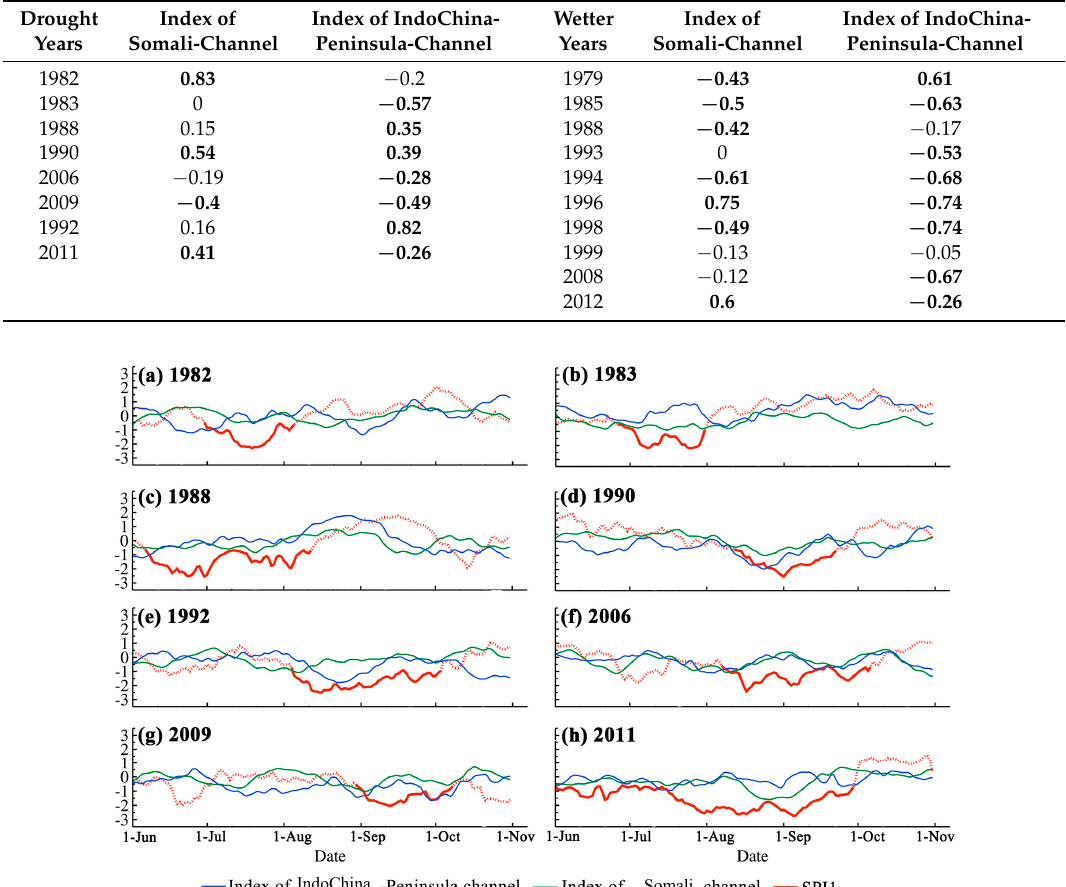
Figure 11. Temporal evolution of SPI1 and indices of identified anomalous channels during severe drought processes. Dotted red curves refer to the SPI1 processes from 1 June to 31 October, whereas solid red curves represent drought processes.